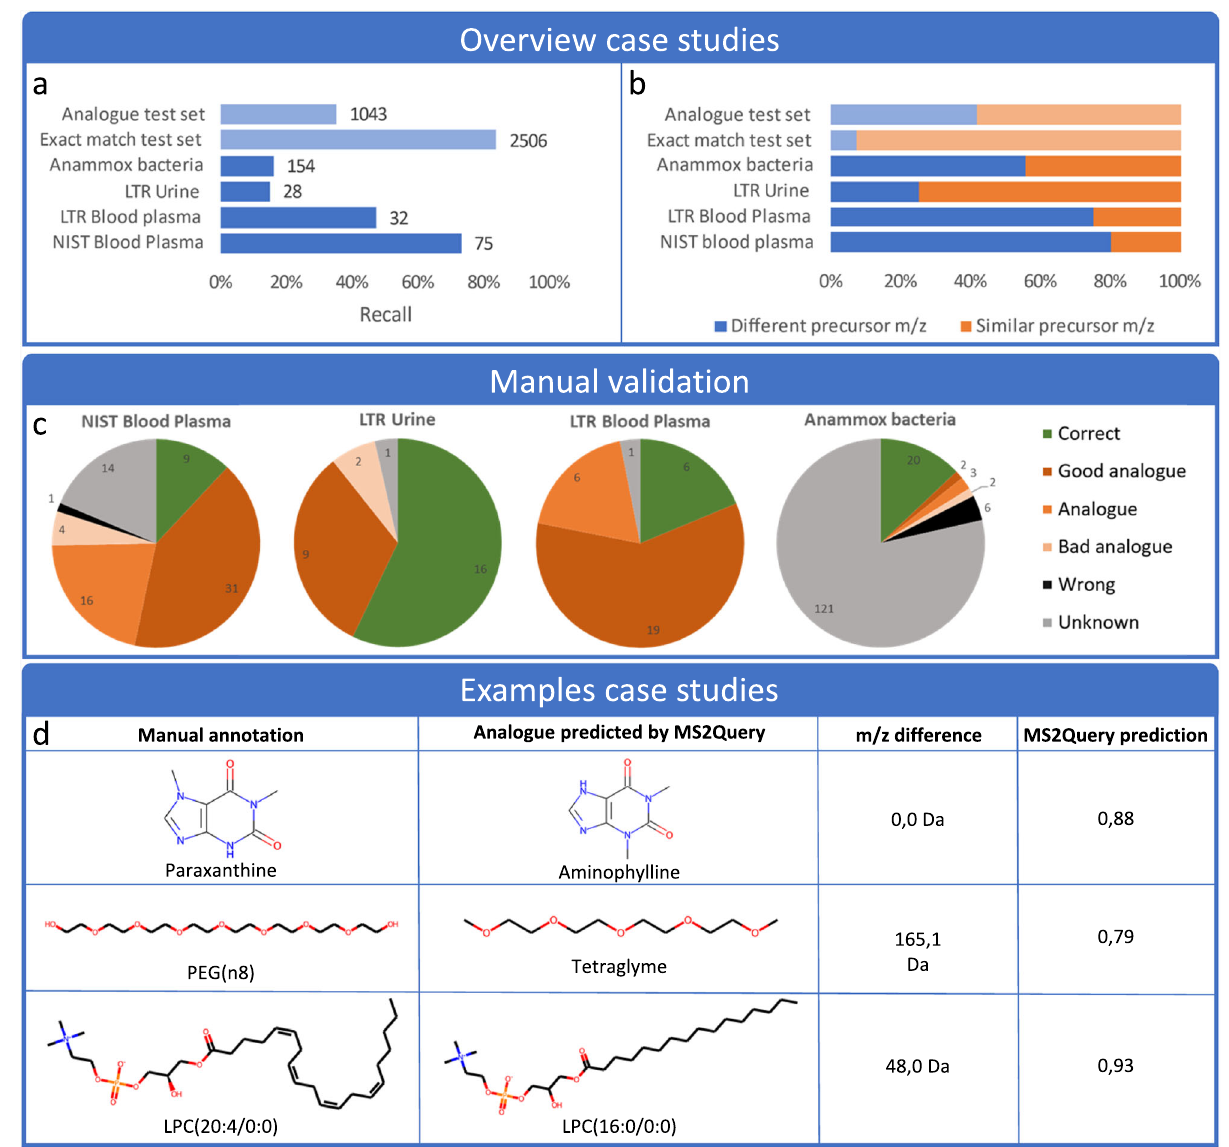
Fig. 3 | Highlights of the results ofthe case studies. The same MS2Query model was used for all test sets, for more details about the model used for the case studies, see Supplementary Note 1. A minimal threshold of 0.633 for the random forest score was used to determine if an analogue was selected. The threshold of 0.633 wasselected,sincethisresultedin arecallof 35% forthe “ analogue test set ” . Sourcedataareprovided asaSource Data fi le. a The variationof recallacrosscase studiesusingthesamesettings. b Thepercentageofqueryspectrawithapredicted analogue (precursor m/z>1Da) is compared to the percentage of spectra with an exact match predicted (precursor m/z<1Da) c Results were manually validated